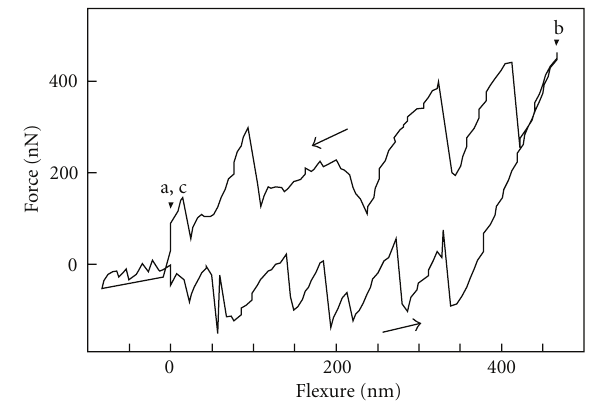
Figure 2: Force-flexure curve of C 70 nanotube during bending shown in Figure 1. Points a–c correspond to the states shown in Figures 1(a)–1(c). The arrows indicate the time path of